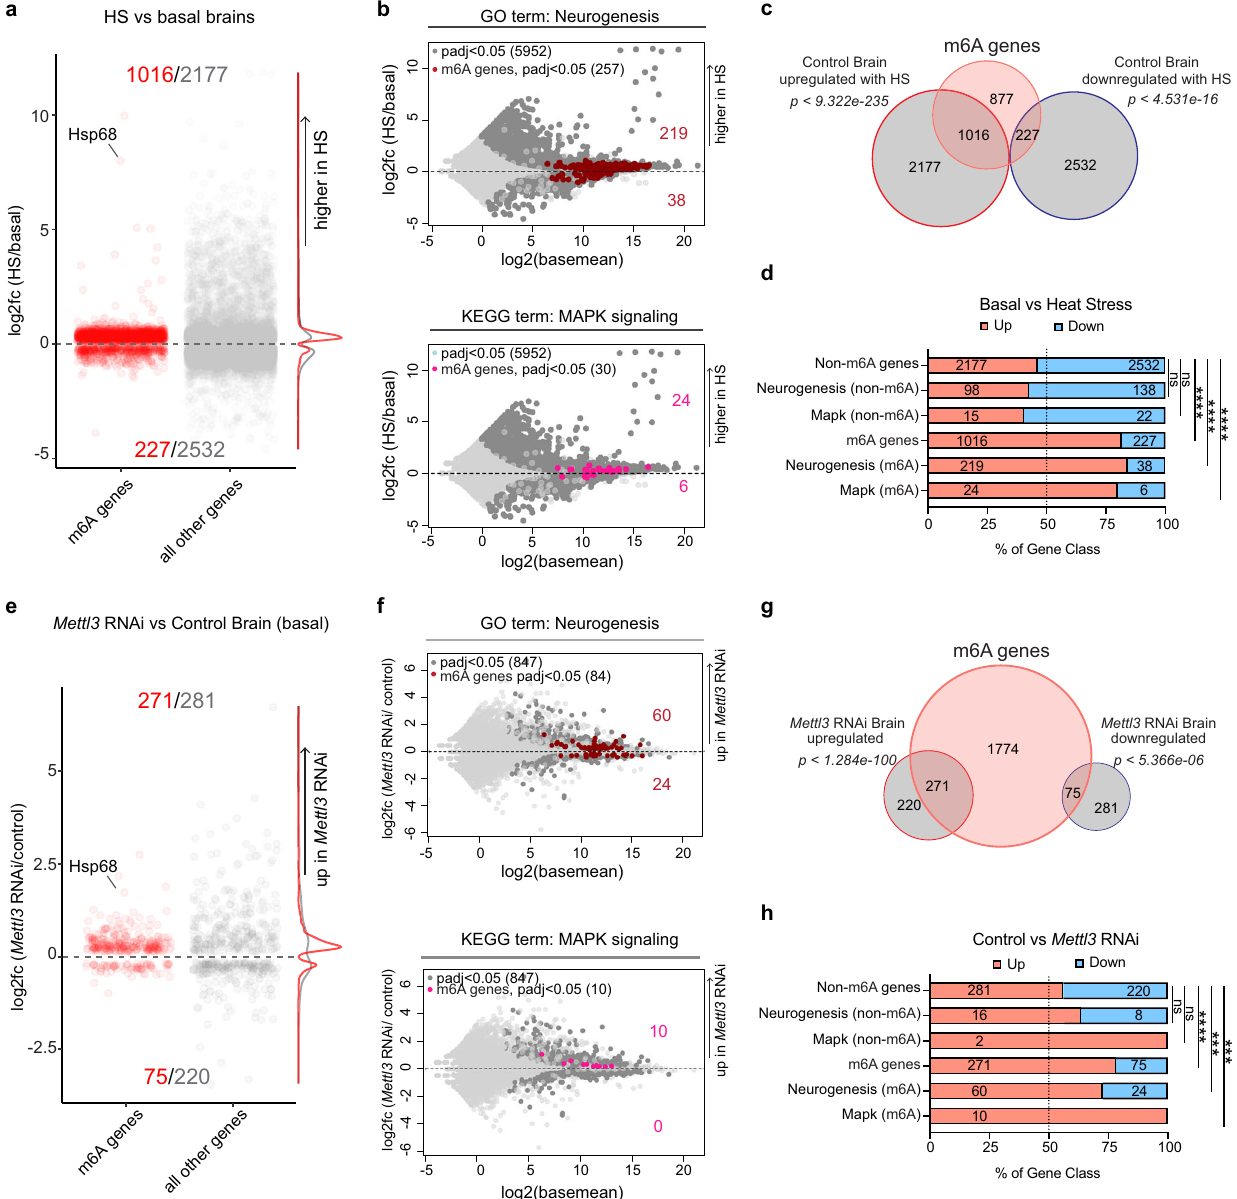
Fig. 4 | m 6 A transcripts are increased with HS and upon Mettl3 knockdown. a Plot of signi fi cantly differentially expressed genes in HS vs basal of control brains (DaGal4 > mCherry RNAi). Positive logFC indicates an increase in transcript levels with HS. m 6 A genes (red), or all other genes (gray). All RNA-seq differential expres- sionanalysisareprovidedinSupplementaryData5. b MAplotsof Mettl3 -dependent m 6 A genes that are enriched in the neurogenesis (GO term) and MAPK (KEGG pathway).PlotsshowcontrolbrainsHSvsbasal(positivelogFCindicatesanincrease with HS brains). c Venn diagram of m 6 A genes that are up or downregulated upon heat stress. Hypergeometric test, one-sided. p <9.322e-235, p <4.531e-16. d Percentage of indicated gene classes signi fi cantly upregulated (red) or down- regulated (blue) in basal versus HS brains RNA-seq. **** p <0.0001 from one-sided Fisher ’ s test. p =0.0003, p <2.2e-16, p <2.2e-16, ns not signi fi cant. e Plot of